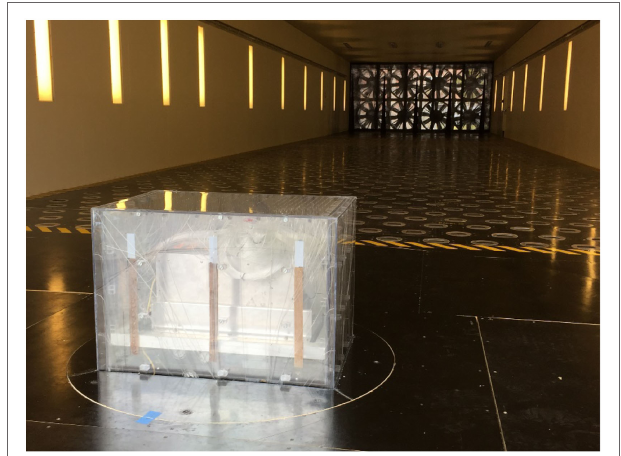
TABLE 1 | Comparison of details of non-stochastic optimization algorithms.